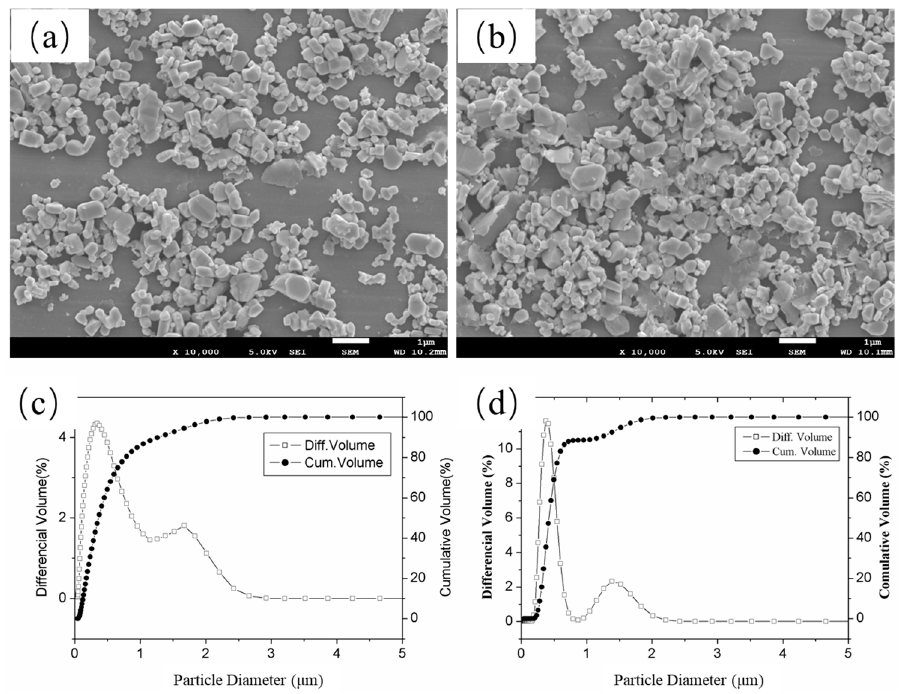
Figure 4. SEM images and particle size distribution of samples obtained following the primary synthesis step ( a , c ) and the second synthesis step ( b , d ) [65].